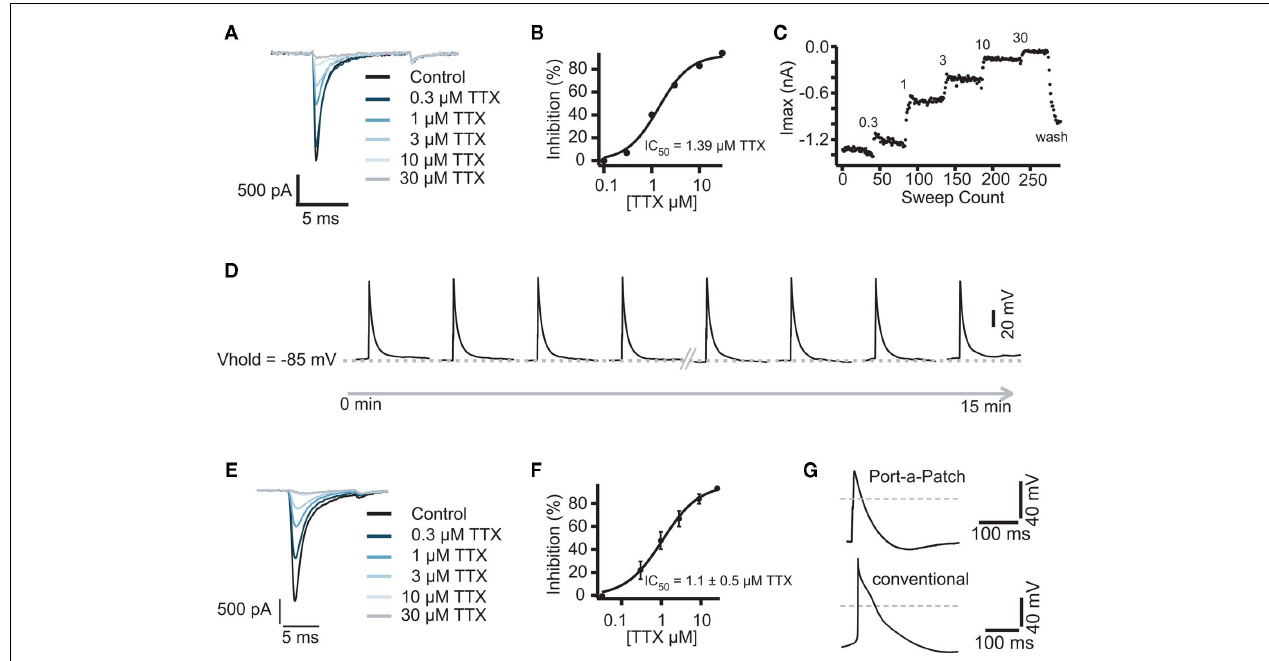
FIGURE 5 | (A) Representative traces of a Cor.At cardiomyocyte recorded in the voltage clamp mode and block by increasing concentrations ofTTX. Raw data of Na + currents in control solution and in the presence of increasingTTX concentrations (0.3, 1, 3, 10, and 30 μ M), elicited by 10ms voltage steps to 0mV from a holding potential of − 80mV, sweep interval 2s. (B) Corresponding concentration response curve with a calculated IC 50 of 1.3 ± 0.4 μ M ( n = 3). (C) Corresponding time plot of the experiment showing the stability of the recording. Current amplitude was reduced step by step upon application of the increasing concentrations. A washout